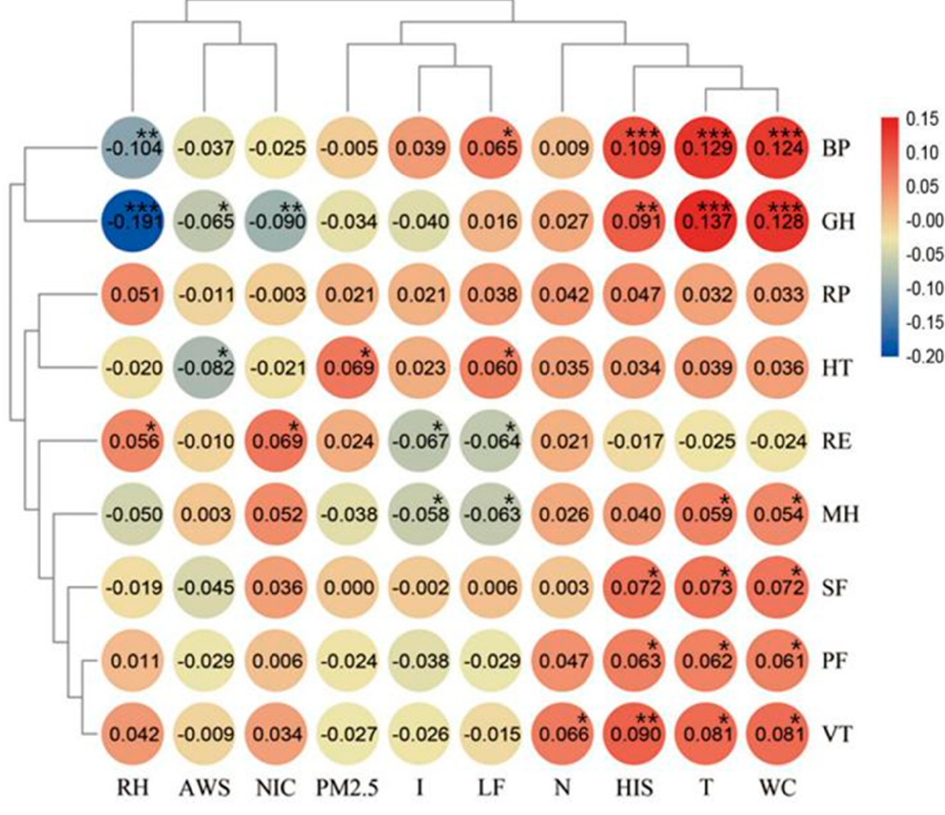
Figure 3. Correlation between environmental factors and health subscales. Note: “***” indicates a significant correlation at the 0.001 level, “**” indicates a significant correlation at the 0.01 level, “*” indicates a significant correlation at the 0.05 level.